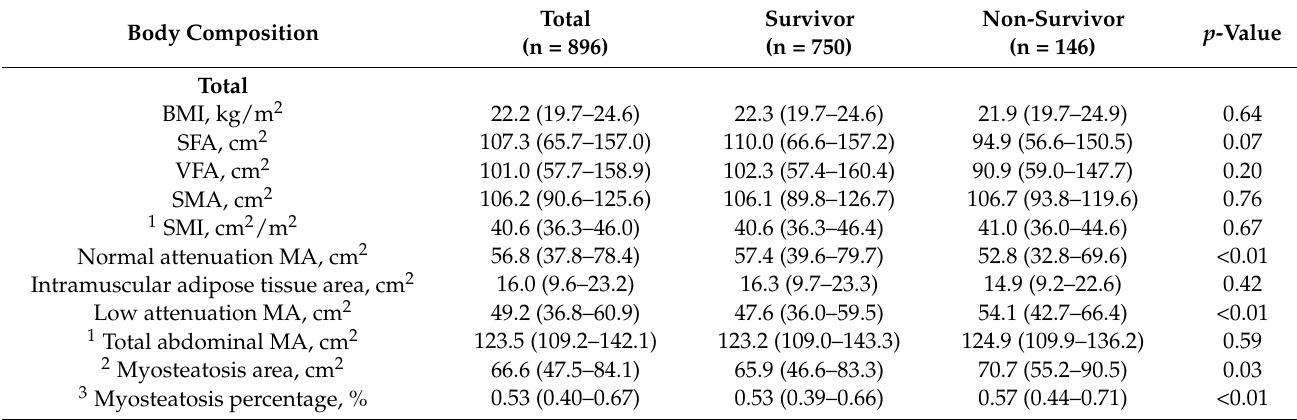
Table 2. Body composition of the study population.